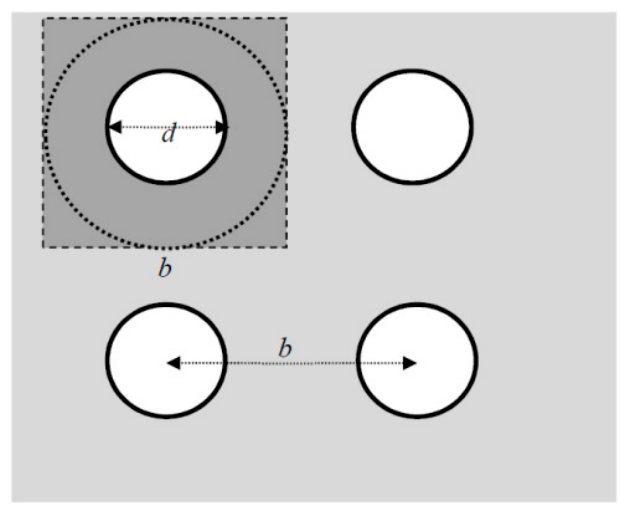
Figure 3. Mass reactance due to the excess of vibrating mass in the hole edges.